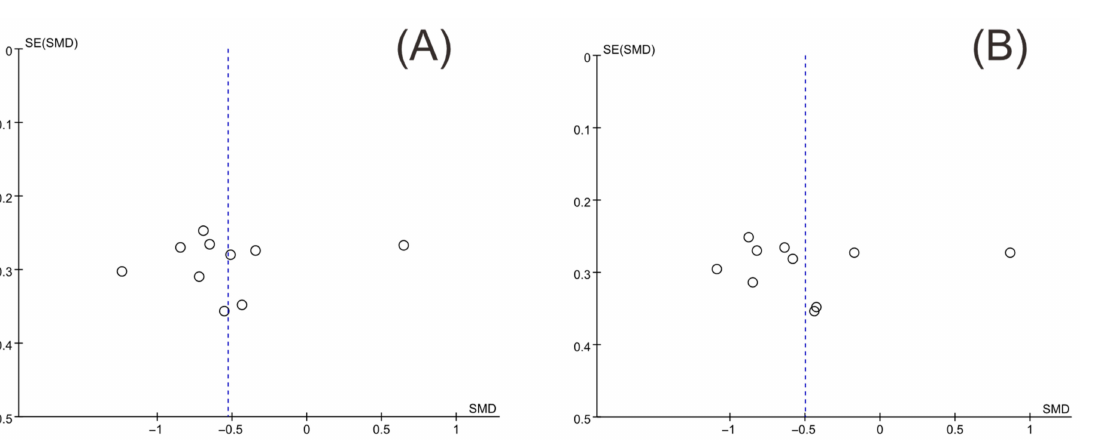
Figure 14. Funnel plot of insulin levels and HOMA-IR. ( A ) Insulin levels, ( B )